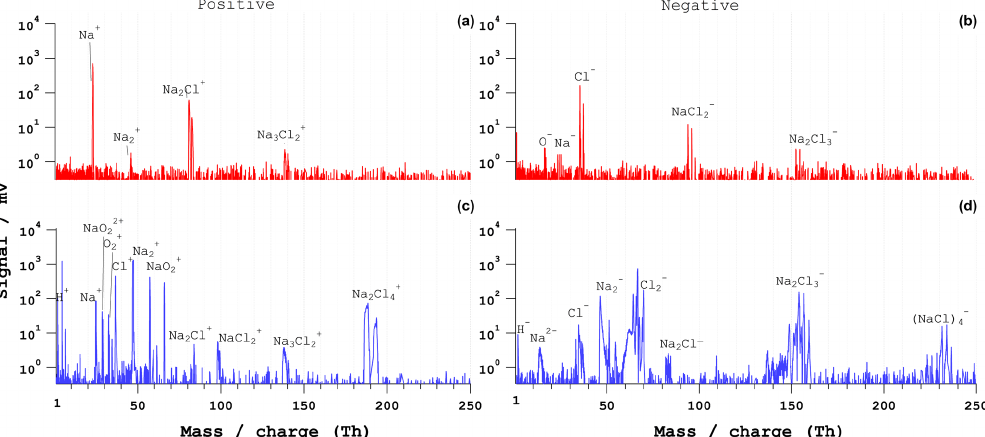
Figure 4. Bipolar mass spectra of NaCl single particles of d m = 400nm. (a, b) Typical ns-laser spectra and (c, d) fs-laser ( λ = 800nm) spectra. The pulse energy is 4mJ for the ns laser and 3.2mJ for the fs laser.